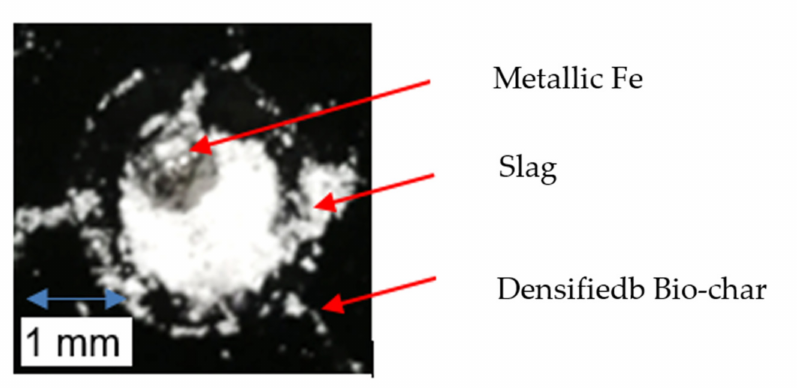
Figure 11. Metallic Fe from the reaction between slag and densified